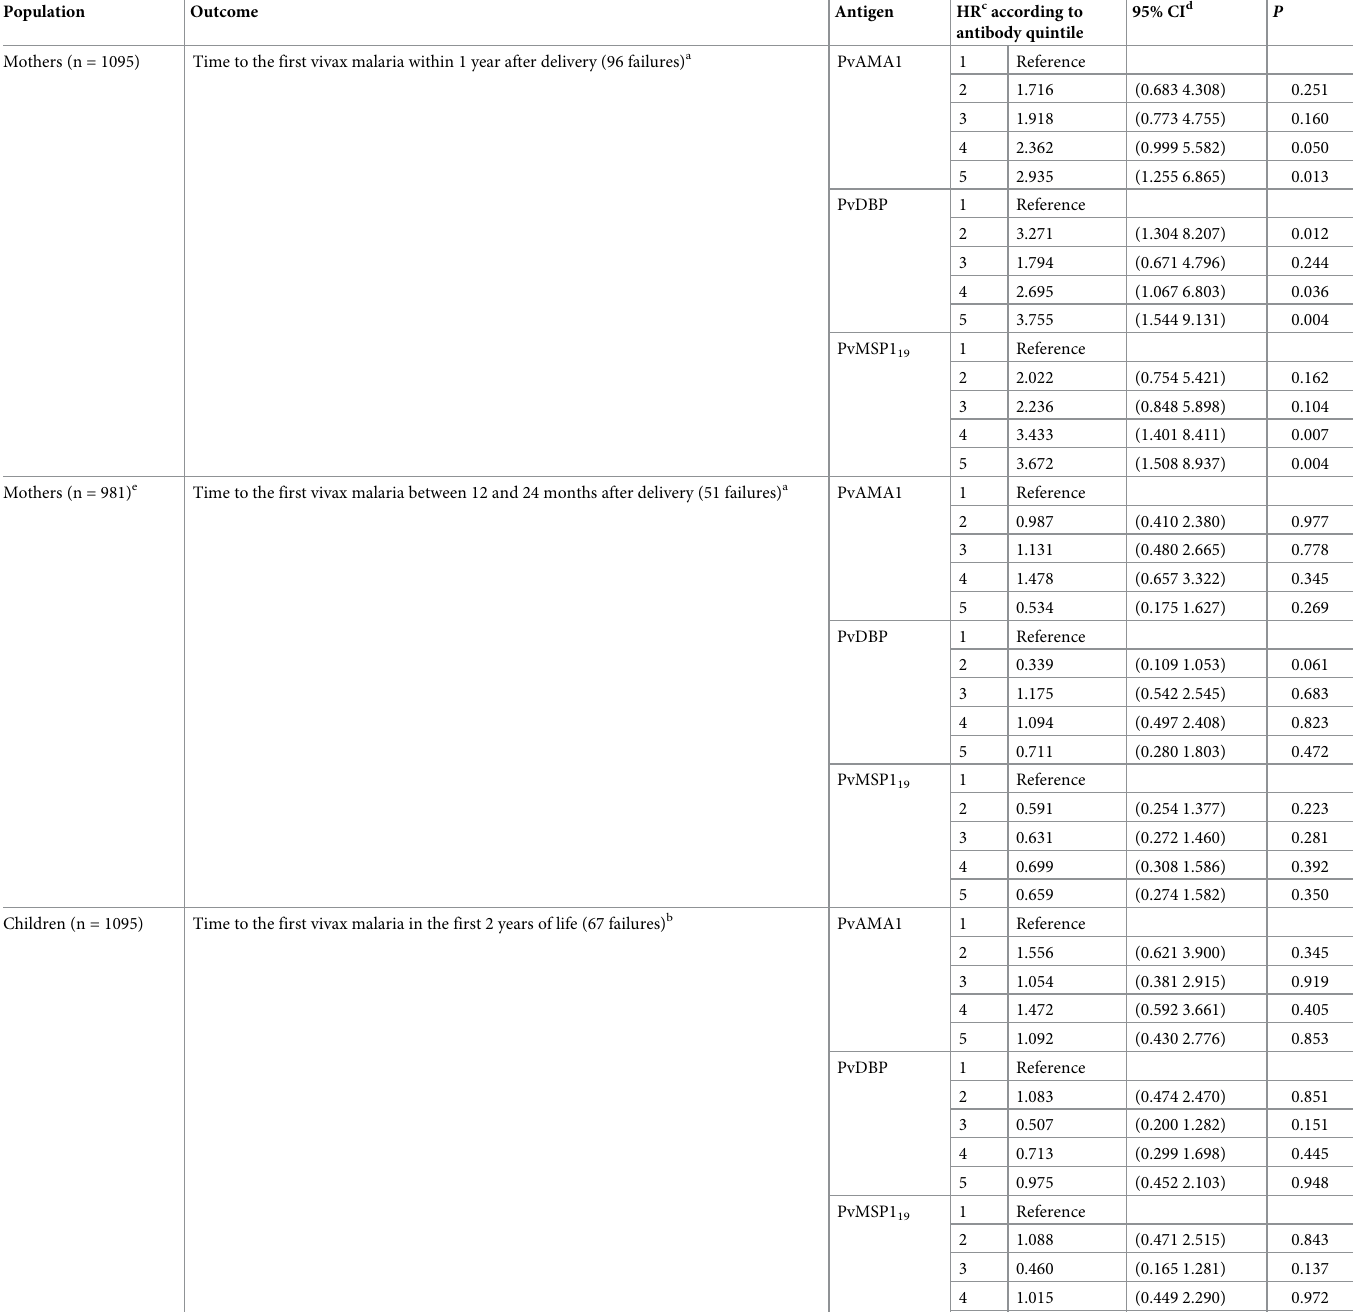
95% CI d P antibody quintile